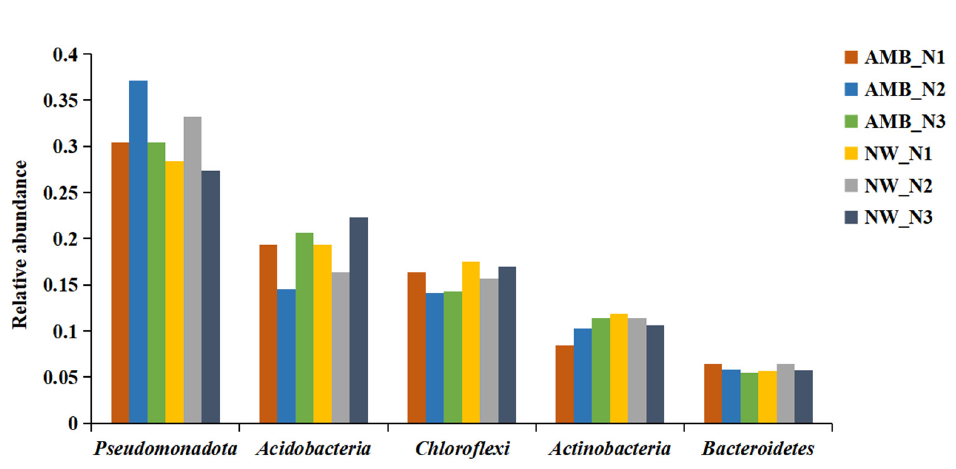
Figure 3. Relative abundance of the dominant soil bacterial phyla under different warming and nitrogen treatments.